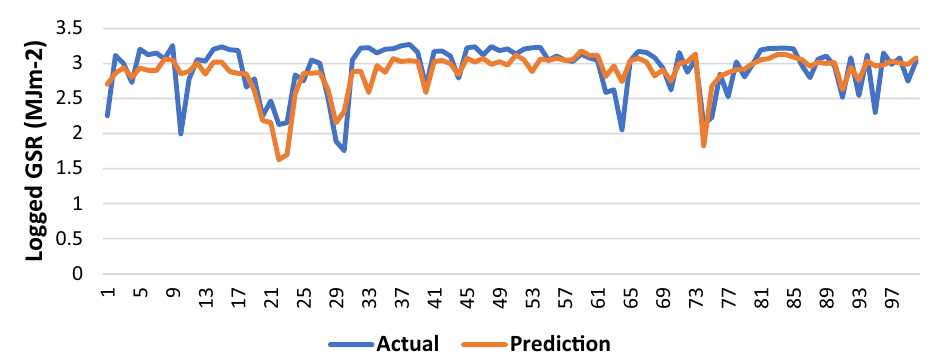
Figure 6. Graph of Actual and Predicted GSR (Model II—LM).